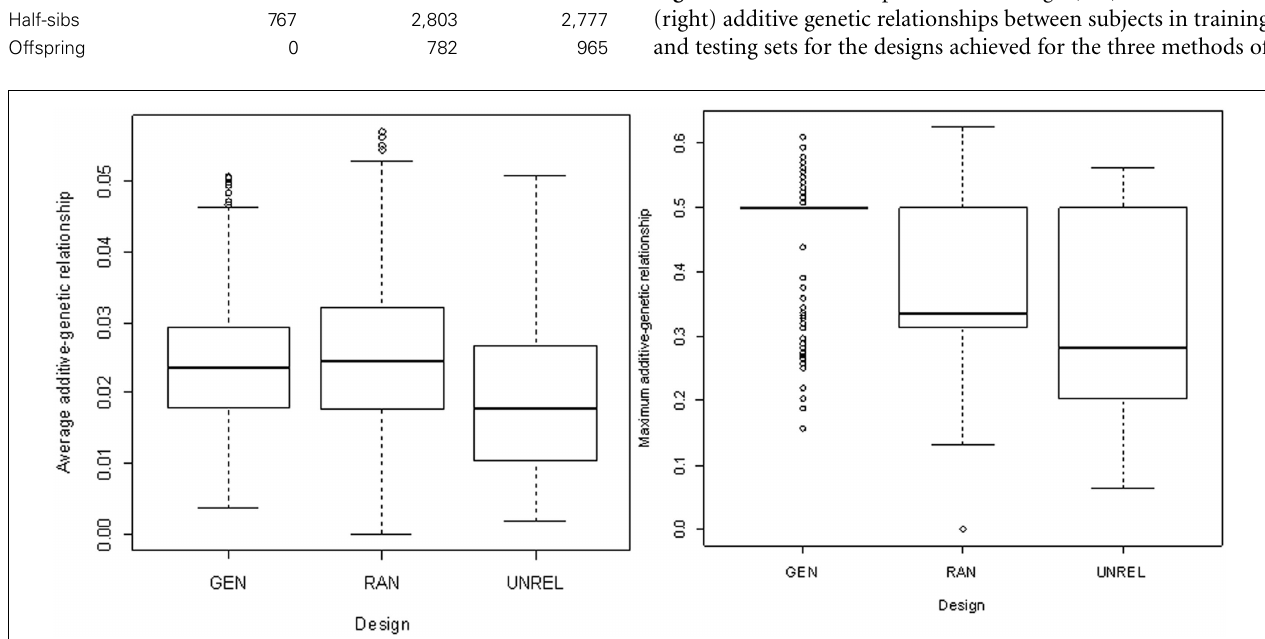
FIGURE 1 | Box plots of average and maximum additive genetic relationships between a testing individual and all individuals in the training set for the generational (GEN), random (RAN), and theA-matrix decomposition (UNREL) designs.